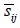
Dynamics of synaptic coupling in the neuronal ensemble with STDP (1) during weak spaced CR stimulation.The neuronal lattices are shown at the end of the stimulation-epochs (left column) (A) 5, (C) 9, and (E) 11, and pause-epochs (right column) (B) 6, (D) 10, and (F) 12 from Fig. 9. Color (except for dark blue) depicts the ensemble-averaged coupling s¯ij of the corresponding neuron to the other neurons within the largest coupling cluster, whereas dark blue indicates the neurons that do not belong to this coupling cluster. Black dots in plots (A), (C), and (E) (left column) indicate neurons that decouple from the main coupling cluster during the consecutive pause-epoch (right column).